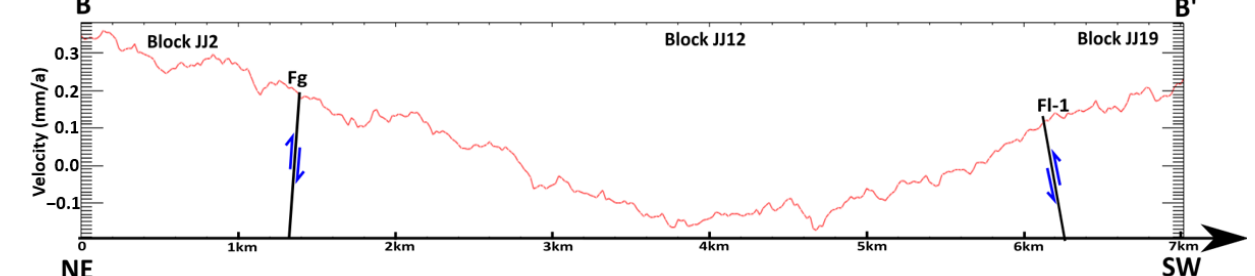
Figure 11. Vertical displacement distribution along cross-section BB’ in Figure 6. This cross-section is formed from 300 PS values sampled along the cross-section line and shows the annual relative movements within each fault block. The marked faults are interpreted from the PS and they are illustrative, showing the sense of fault movement and general direction of faults.